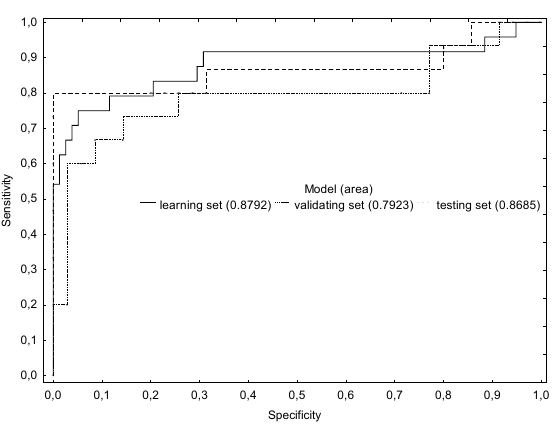
Figure 3. Receiver Operating Characteristic (ROC) curves with the values of areas for the training, validating and testing set.